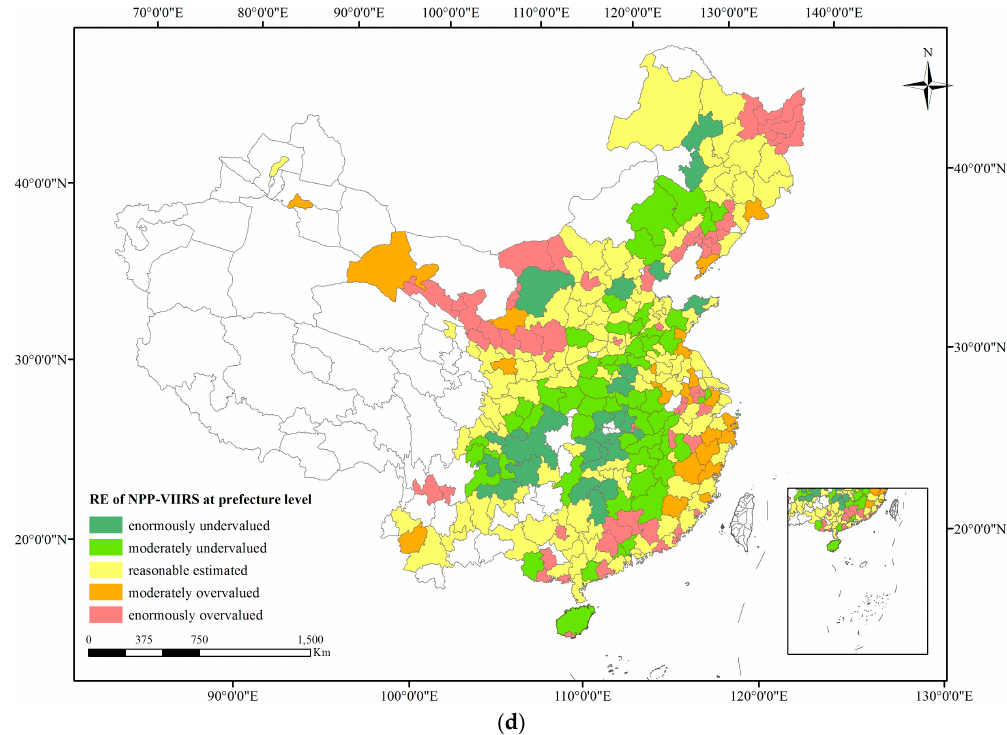
Figure 4. The REs of DMSP-OLS and NPP-VIIRS at prefecture level: ( a , c ) the underestimated and overestimated regions for DMSP-OLS and NPP-VIIRS, respectively; and ( b , d ) the spatial distributions of REs across the five classes for DMSP-OLS and NPP-VIIRS, respectively.